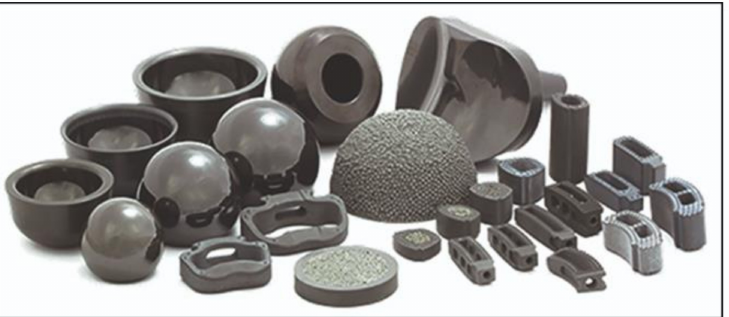
Figure 5. Various silicon nitride compacts produced by SINTX Technologies, Salt Lake City, UT, including ball bearings (left), an acetabular cup (center), an intervertebral spacer with a CSC core (fore- ground, center), and spinal interbody fusion devices (right) [22]. © Creative Commons